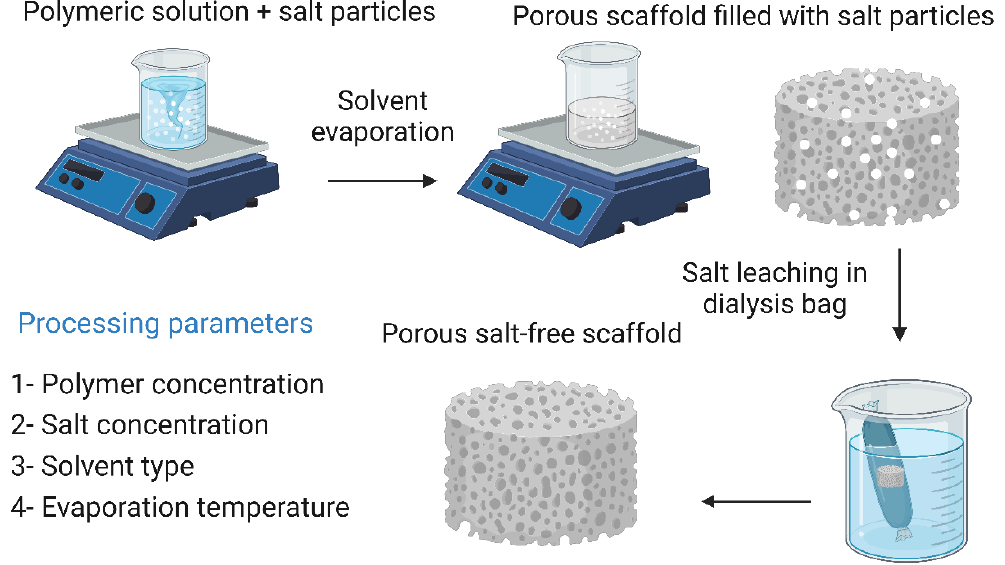
Figure 9. Solvent casting and particulate leaching technique and its processing parameters. The image was created using Biorender.